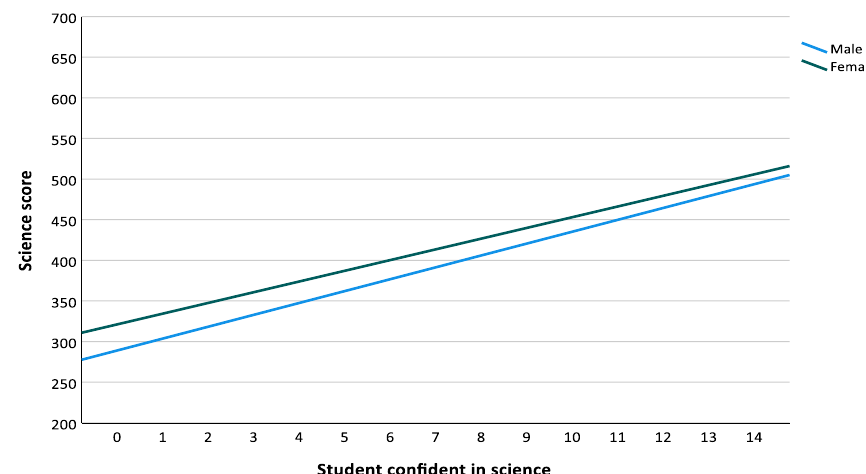
Fig. 9 Interaction between gender and student confident in science on science achievement, grade 8. The plot presents the predicted values from step 7 of the science model for grade 8 (Table 11)